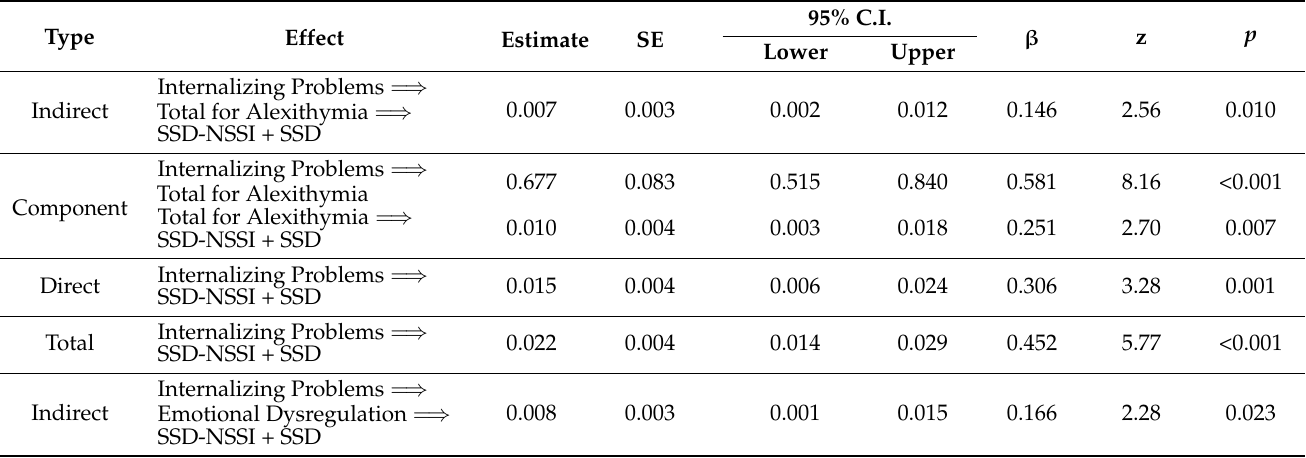
Figure 1. Mediation role of alexithymia and emotional dysregulation. Table 4. GLM Mediation